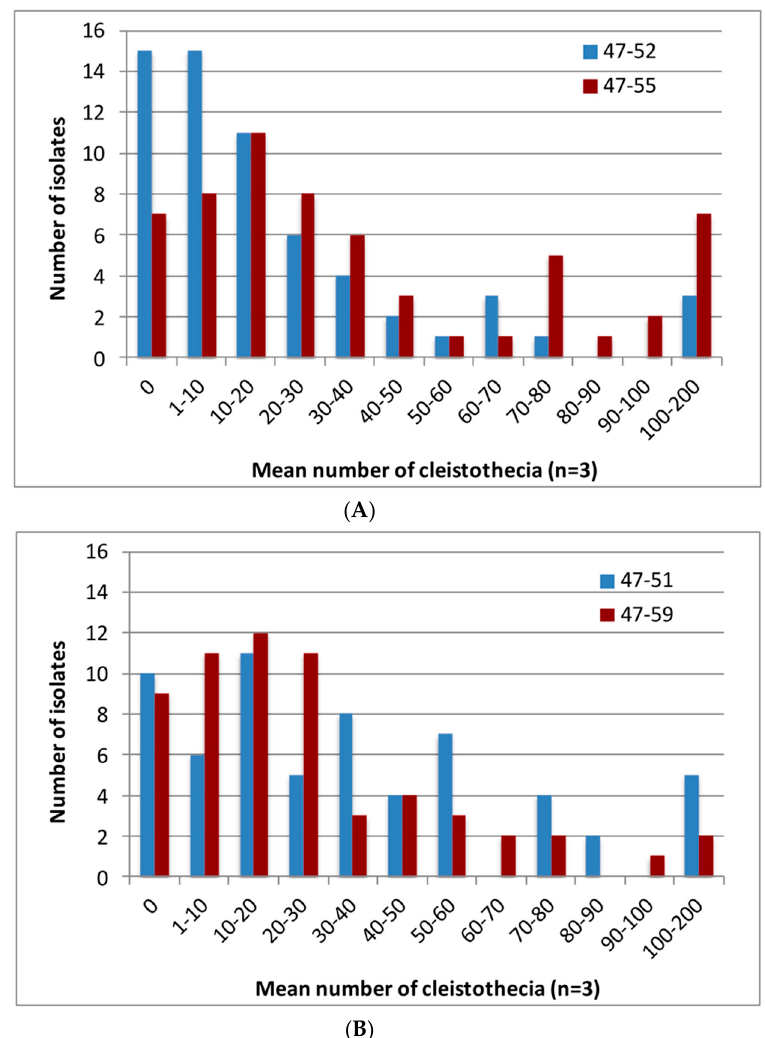
Figure 2. Variation in mean number of cleistothecia produced in crosses with different worldwide isolates of A. fumigatus . ( A ) Numbers of cleistothecia produced by MAT1-1 global isolates (per 9 cm Petri dish), in crosses with two Irish MAT1-2 tester strains (47-52, 47-55). ( B ) Numbers of cleistothecia produced by MAT1-2 global isolates (per 9 cm Petri dish), in crosses with two Irish MAT1-1 tester strains (47-51, 47-59). Left hand axis shows the number of isolates producing the mean number of cleistothecia shown on axis below.